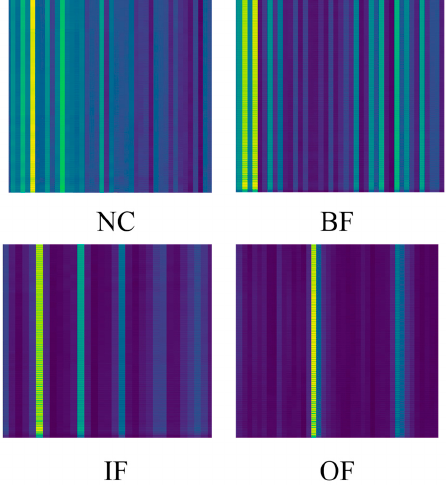
Figure 12. Converted images on four operating conditions.